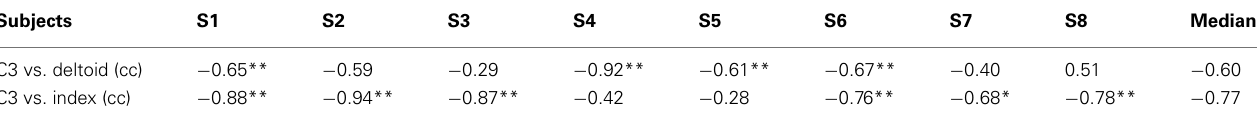
Table 3 | Signal correlations between the lower MER2 component at the electrode position C3 and EMG activity. Subjects